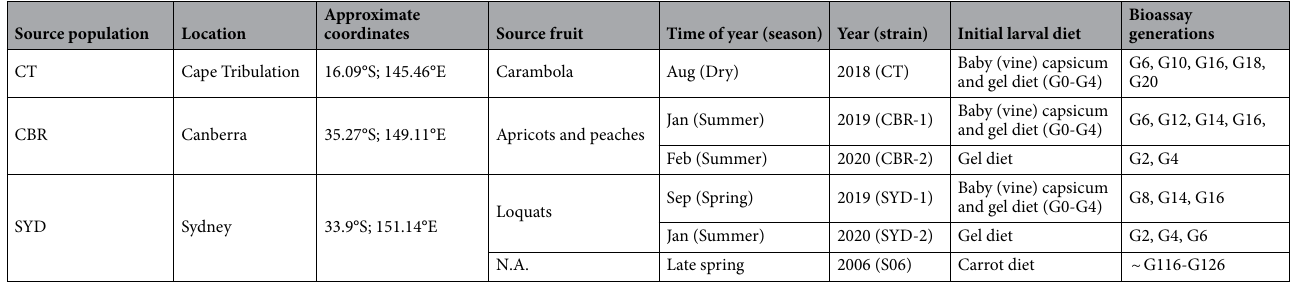
Table 1. Qfly source populations and strains used in this